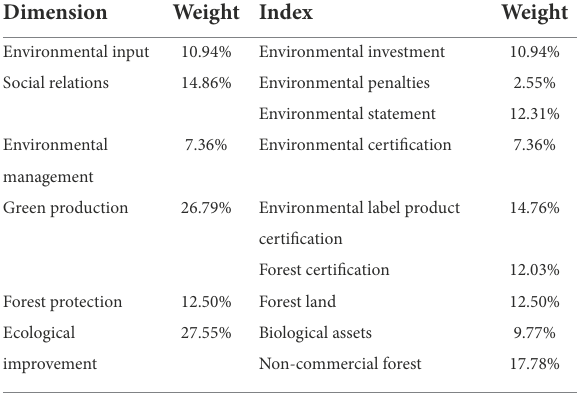
TABLE 7 Weight of each